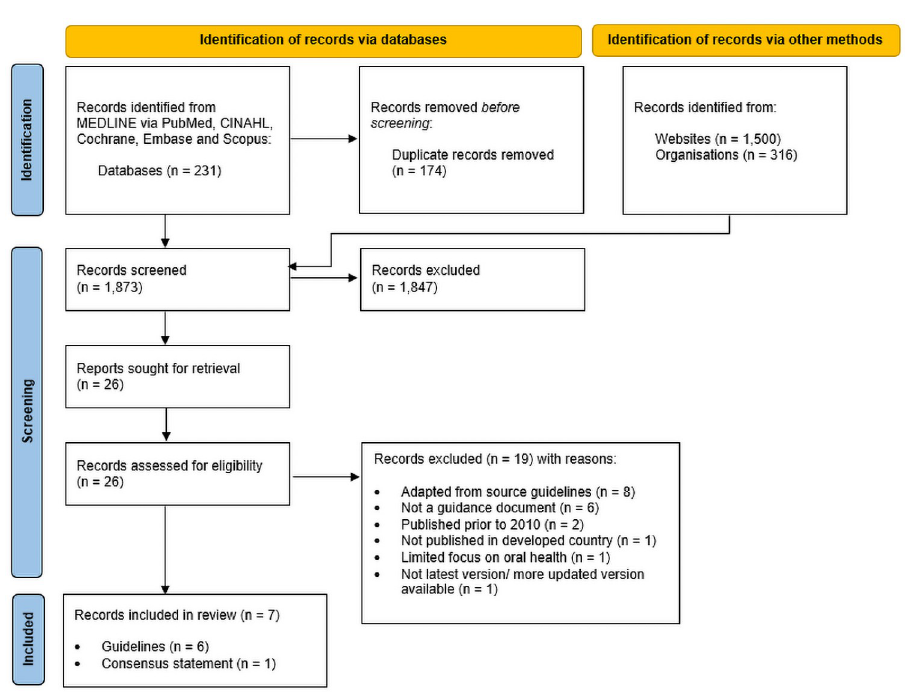
Fig 1. Flow chart of the systematic literature search and